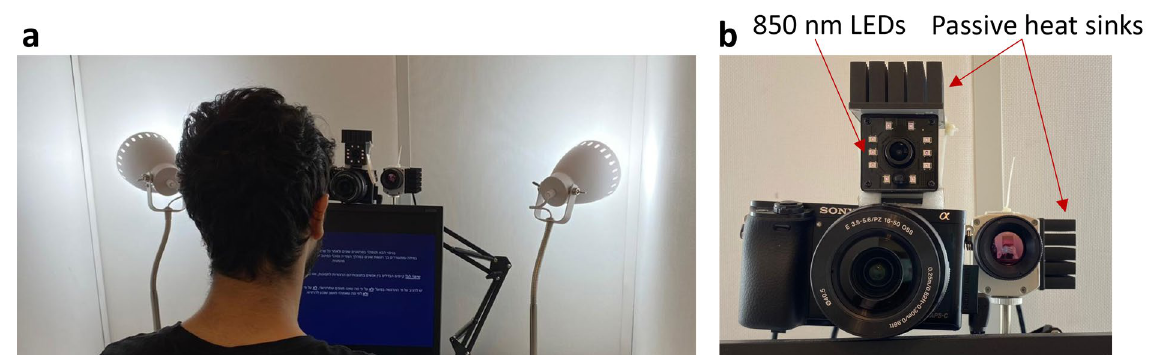
Figure 8. Experimental setup: ( a ) A photo taken during one of the experiments, depicting the environment. ( b ) The three cameras that simultaneously recorded the face: RGB camera (bottom left), active NIR camera with illuminating LEDs around it (top), and LWIR camera (bottom